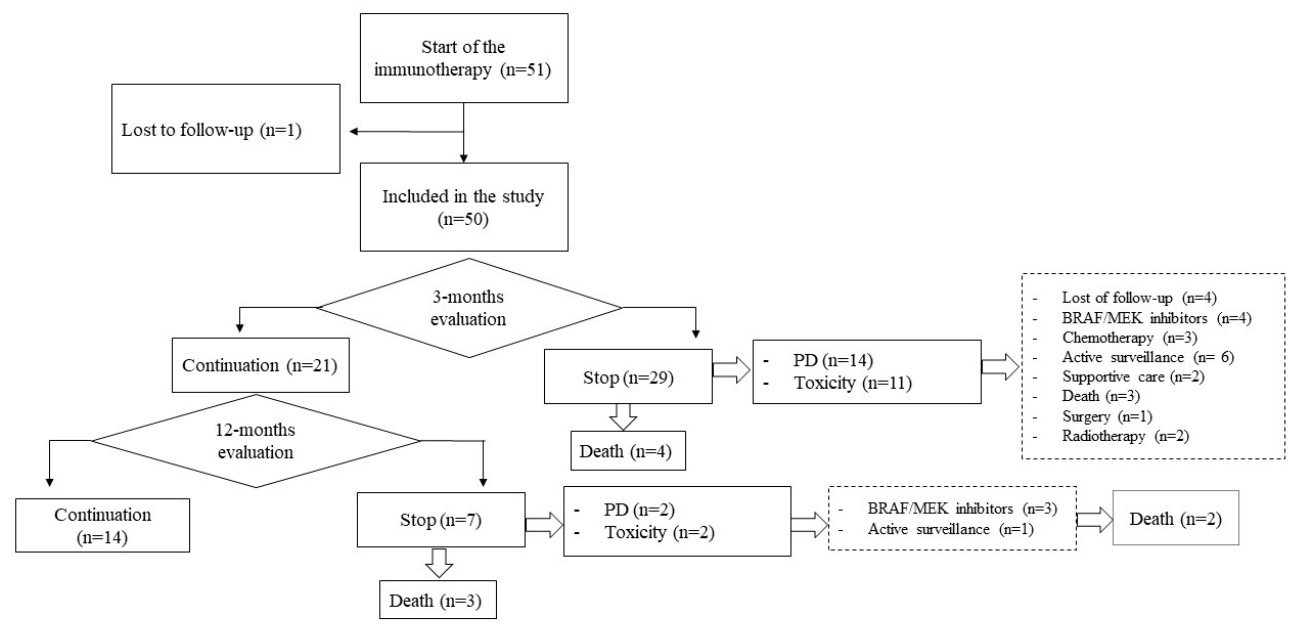
Figure 1. Profile of enrolled patients.